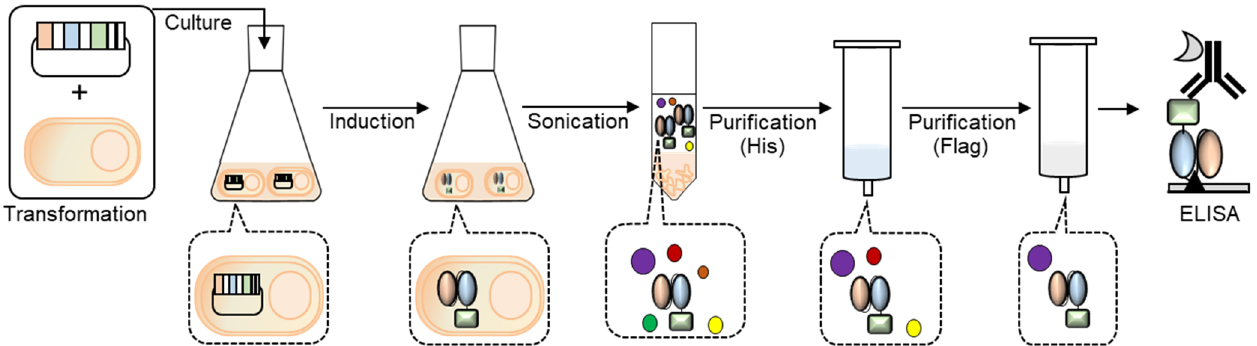
Figure 1. Scheme of the generation of Neo2/15-conjugated recombinant anti-PD-L1 scFv.